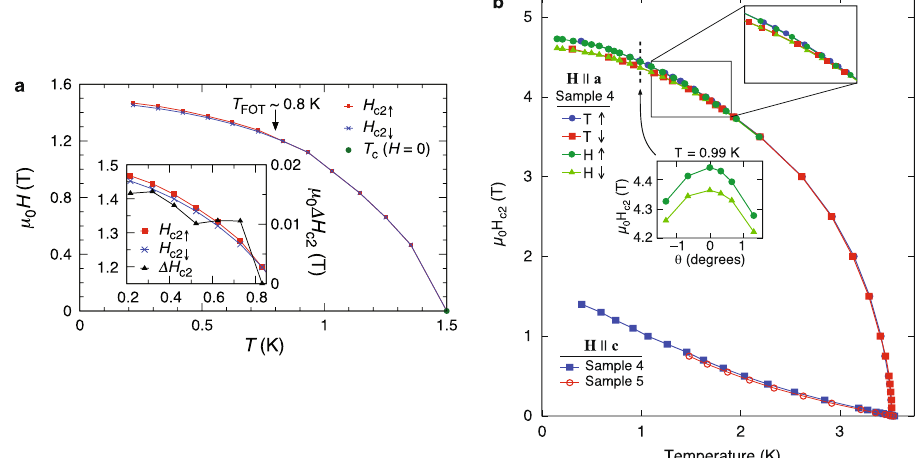
Fig. 6 Critical fi eld limiting is seen in both T c = 1.5 K Sr 2 RuO 4 in ambient conditions ( a )) 86 and in strained T c = 3.5 K material ( b )). 42 In both cases, there is evidence for a fi rst order transition at low temperatures and high fi elds. This is a feature of simple theories of paramagnetic limiting in even parity superconductors 85 but might also be expected for magnetic limiting in spin-orbit coupled odd parity superconductors. 89 ( a reproduced with permission from ref. 86 copyright American Physical Society 2013) ( b from ref. 42 reprinted with permission from T (Fig. 6a) 84 and the transition at low temperatures is fi rst-order, as intrinsic anisotropy parameter of the superconducting state, which determines the anisotropy of critical fi elds based on diamagnetic expected for Pauli limiting 85 rather than the second-order orbital limiting to be 60. 83 This would predict a critical fi eld of transition expected for diamagnetic orbital limiting. 86 – 88 Further, approximately 4.5 T for H //ab . In contrast, the measured value is 1.5 the value of 1.5 T is semi-quantitatively consistent with the value